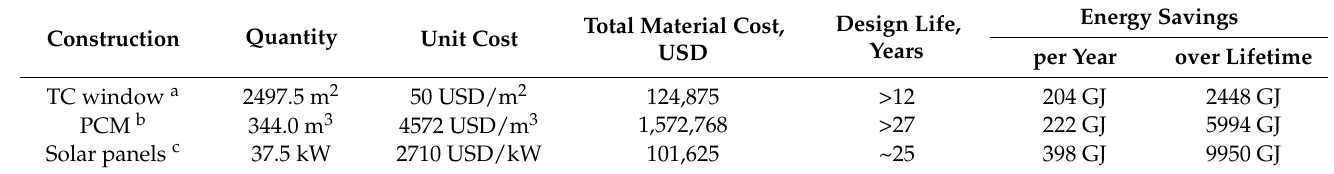
Table 6. Material quantities, costs, and energy savings by thermochromic windows, PCMs, and solar panels. Construction